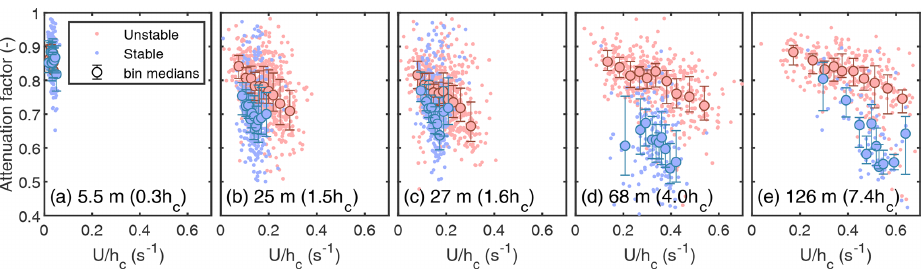
Figure 4. Dependence of AF on U/h c at different mast heights. The 30min values (points), bin medians (filled circles) and the bin in- terquartile range (error bars) are shown. Data were screened based on flux stationarity (Foken and Wichura, 1996) and values for temperature | > 0 . 02K 2 and | w (cid:48) T (cid:48) | > 0 . 015Kms − 1 variance and w (cid:48) T (cid:48) before plotting ( | σ 2 T